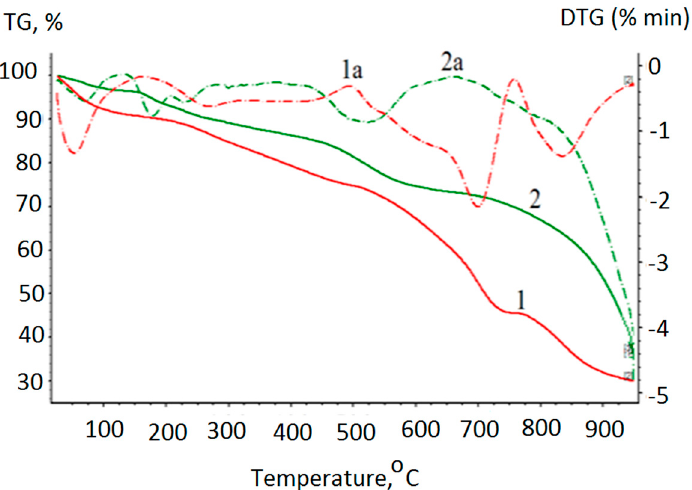
Figure 5. Differential thermal analysis (dashed line, DTA) and thermogravimetric analysis (solid line, TG) curves with endo- and exothermic peaks for thermal decomposition of I (red line) and Cu-[I-Cu] 6 (green line). Table 3. Thermogravimetric analysis data of the II and its hexamer.